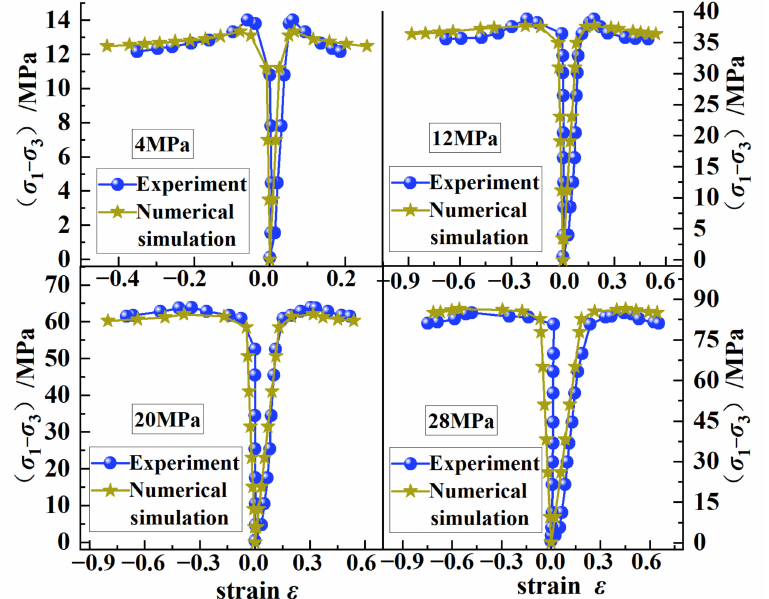
Figure 8. Stress–strain curves of laboratory test and simulation